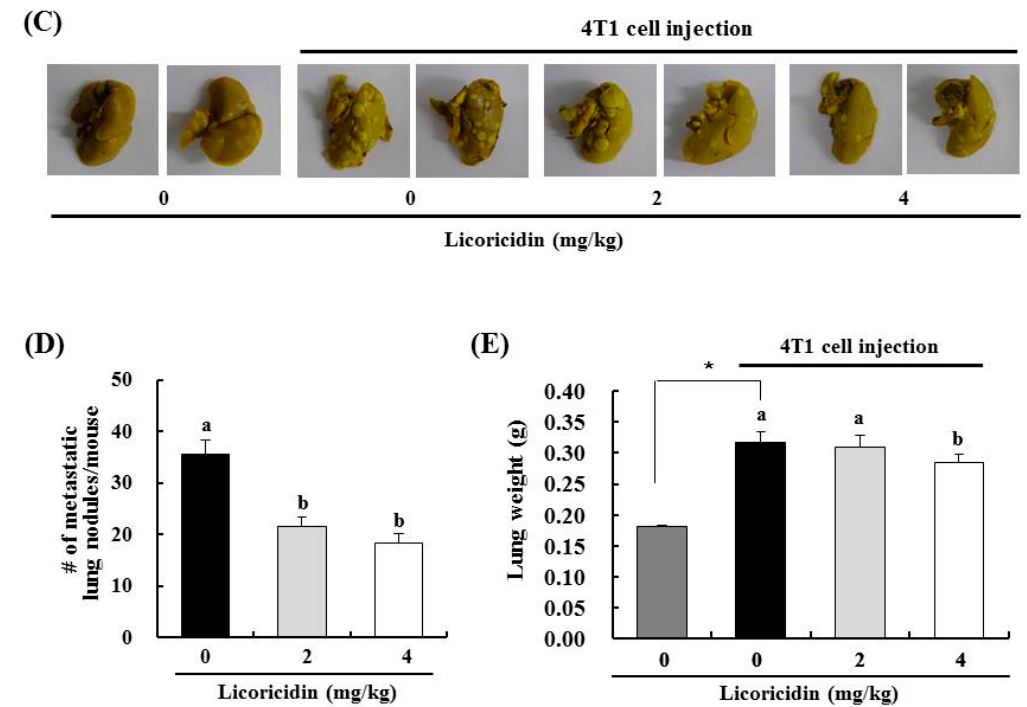
Figure 3. Licoricidin inhibits lung metastasis in BALB/c mice injected with 4T1 cells. ( A ) Chemical structure of licoricidin. 4T1 cells were injected into the inguinal mammary fat pads of female BALB/c mice. For 21 days, beginning on the date of 4T1 cell injection, the mice received intraperitoneal injections of vehicle or licoricidin (2 or 4 mg/kg body weight/day); ( B ) Tumor weight was measured at the time of sacrifice; ( C ) Photographs of the lungs, which are representative of 20 animals; ( D ) The number of tumor nodules; ( E ) Lung weight. Each bar represents the mean ± SEM (normal control, n = 8; 4T1 cell-injected, n = 20). * Significantly different from the normal control group, p < 0.05. Means without a common letter differ among the tumor cell-injected groups, p < 0.05.